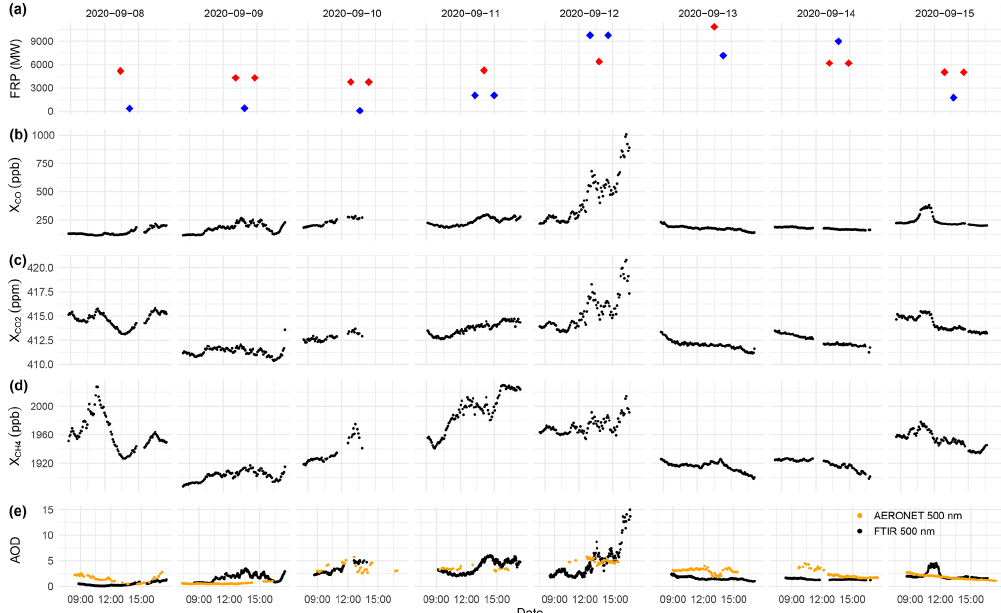
Figure 2. Time series during the first week of measurements for 8–15 September 2020. (a) Daytime total FRP from VIIRS NOAA-20 of Creek Fire (red) and SQF Complex (blue). (b–d) The 5min mean observations from the ground-based EM27/SUN solar-viewing spectrom- eter of X CO , X CO , and X CH . (e) FTIR-derived AOD (black) and AERONET AOD at 500nm (orange). 2 4